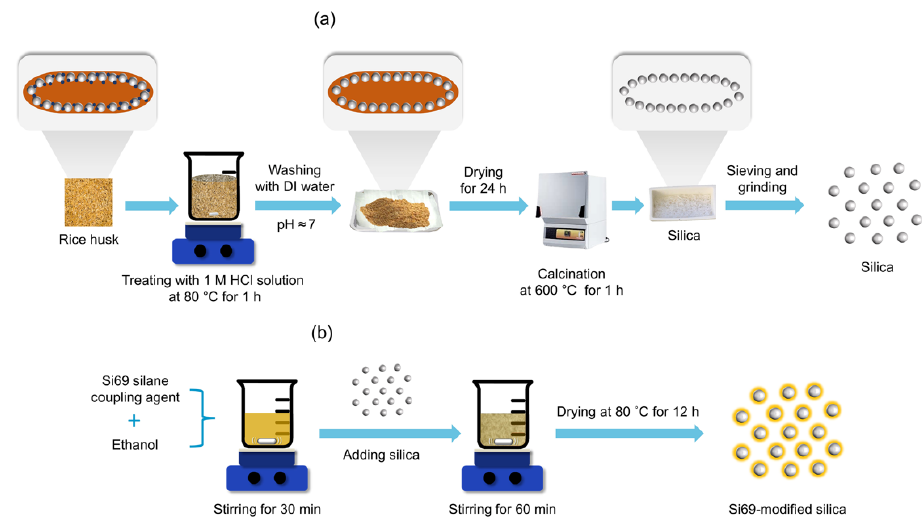
Figure 1. Schematic illustration showing the preparation processes of ( a ) silica from rice husk and ( b ) silane-modified silica.